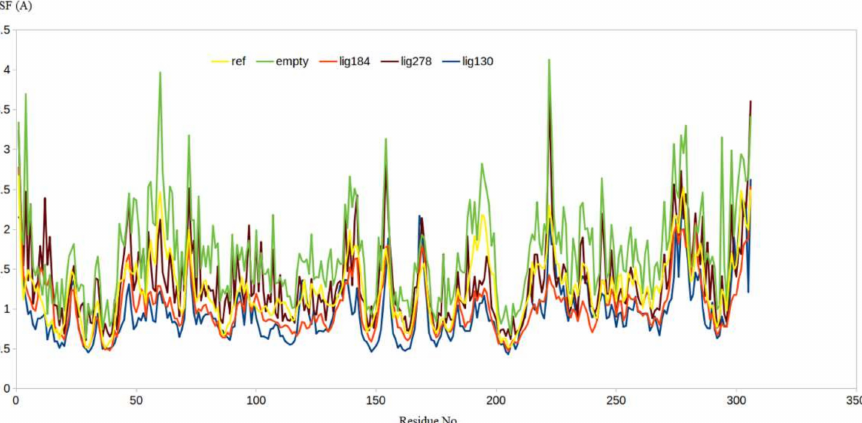
Figure 10. The RMSF analysis for the MD simulations for the native enzyme (orange), PRD_002214 (blue), 130 (brown), 184 (yellow), and 278